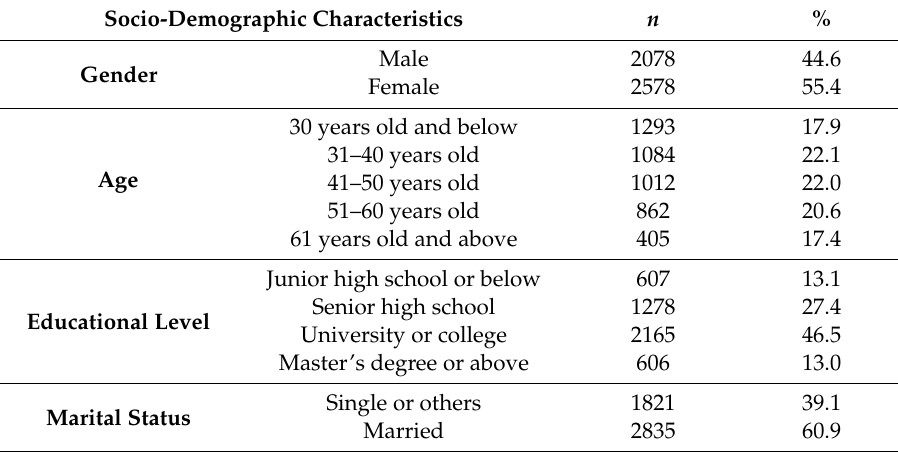
Table 1. Socio-demographic characteristics of